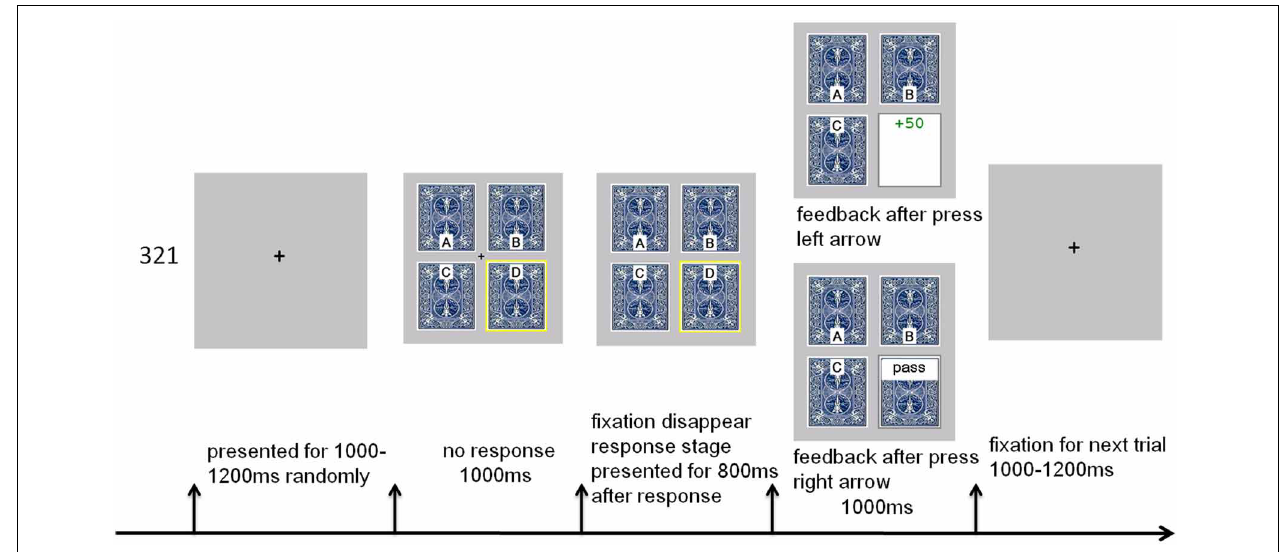
FIGURE 1 | Experimental flow of the IGT